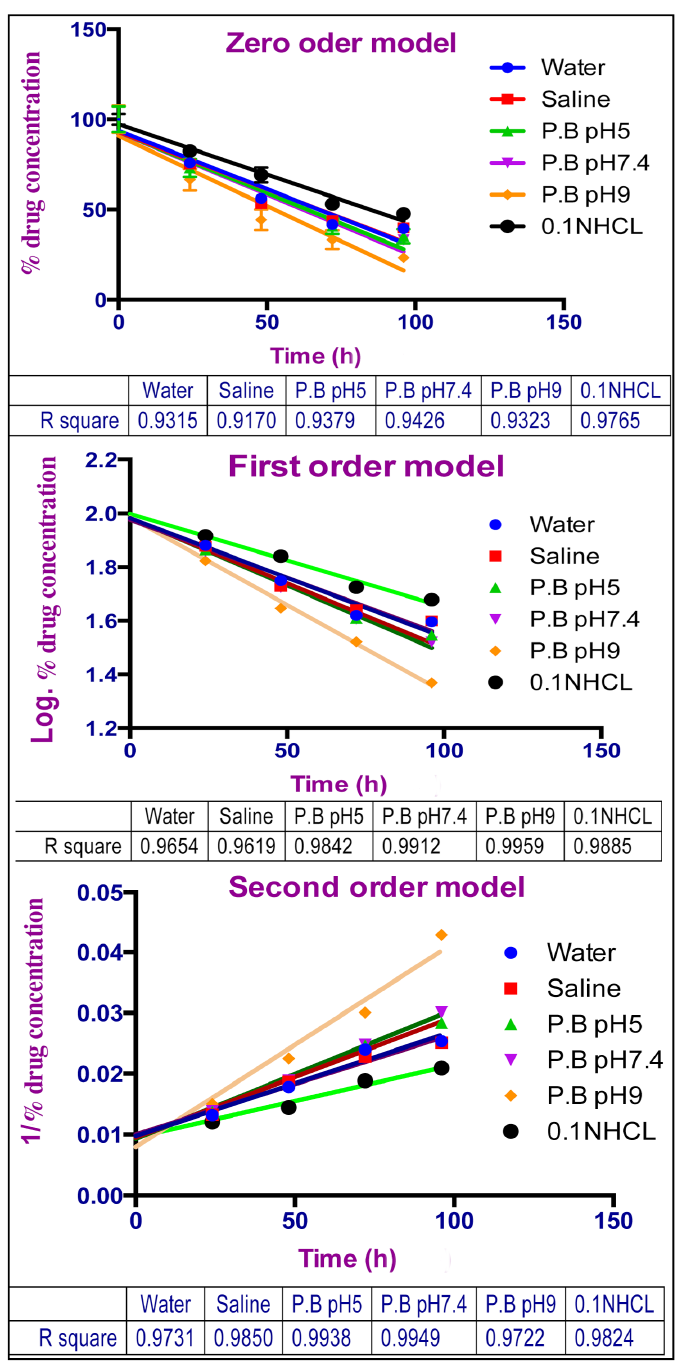
Figure 5. Degradation kinetics of TQ in aqueous media, zero order, First order, and second order kinetics